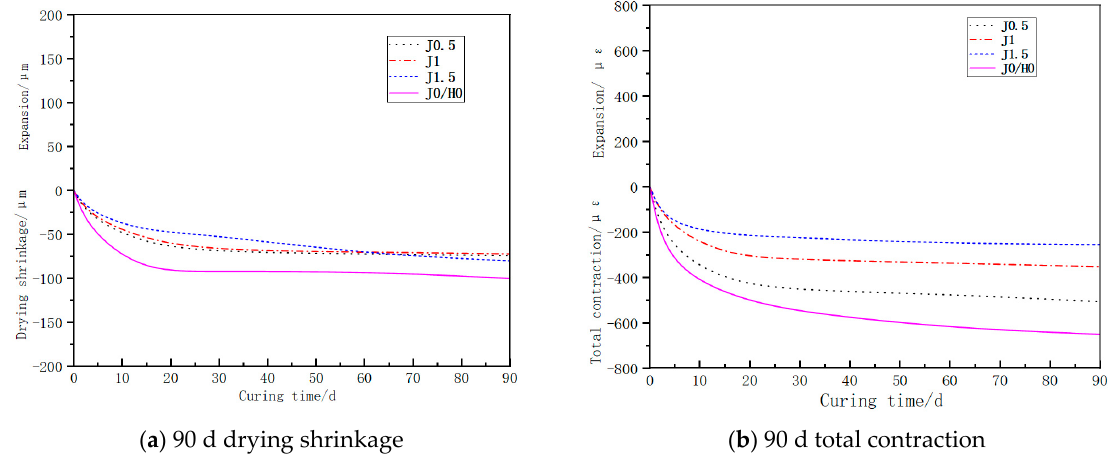
Figure 9. Effect of shrinkage-reducing agent on concrete drying and total shrinkage.